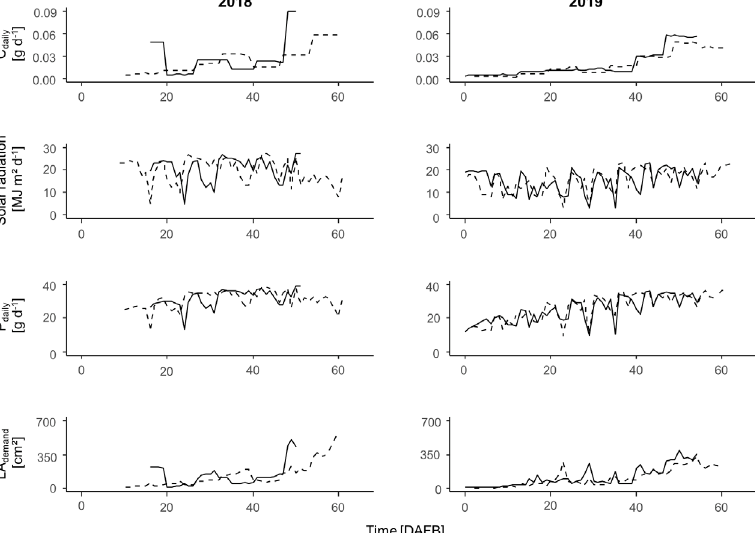
Fig. 6: Time course of changes in total carbon demand per fruit, C daily , solar radiation, S, estimated carbon assimilation, P daily , and daily leaf area demand per fruit, LA demand , of developing 'Bellise' (solid line) and 'Regina' (dashed line) sweet cherries in the growing season 2018 and 2019 under the assumption that 50 % of the assimilated carbon is partitioned to Tab. 1: Leaf area demand [cm²] of sweet cherry fruit considering the 8 day interval in two years. Values in parenthesis are mean values with local maxima excluded, compare Fig. 6. Cultivar/Year